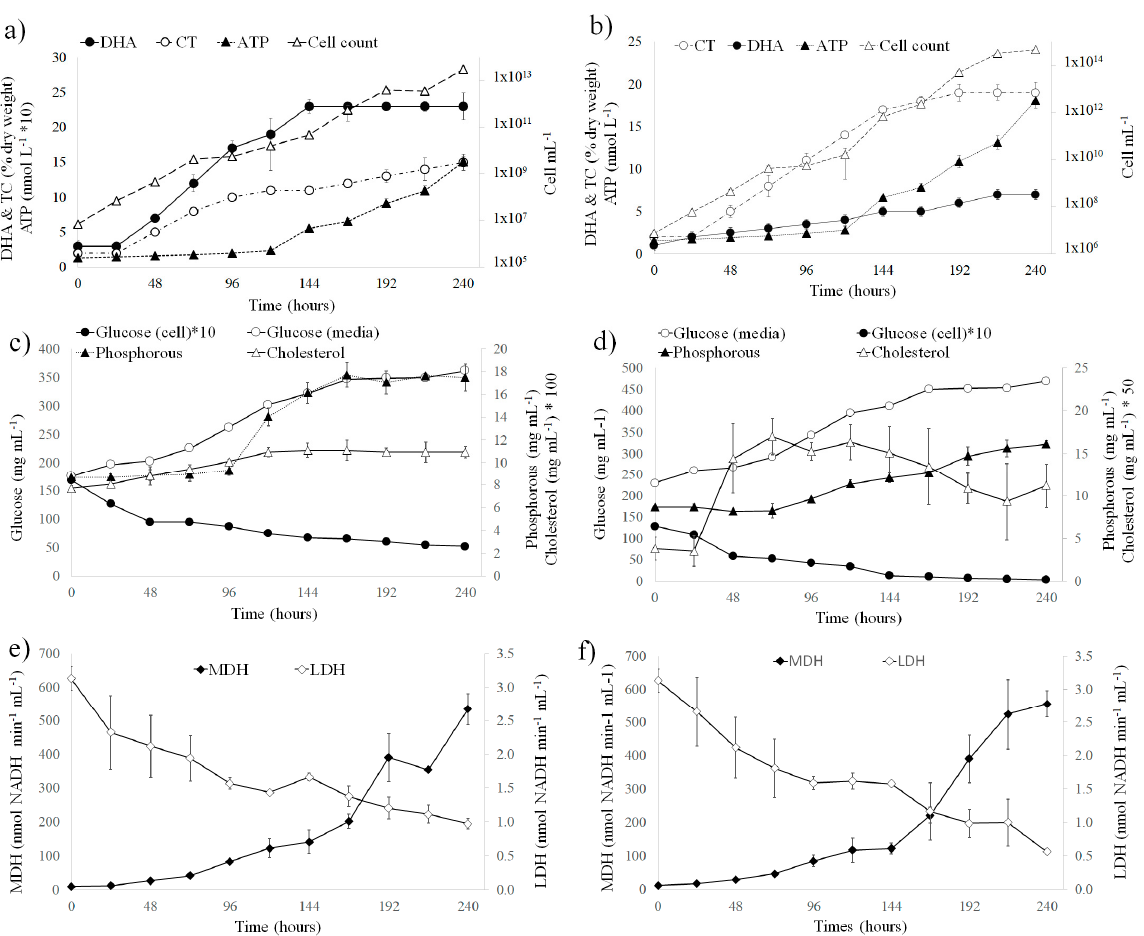
Figure 4. Average production ± SD of metabolic parameters determined for the NCYC4007 and NCYC1146 strains, cultivated in RGM at 15 ◦ C. ( a , b ) Docosahexaenoic acid production (DHA), total carotenoids (TC), live microbial biomass (ATP) and cell count of strains NCYC4007 and NCYC1146, respectively. ( c , d ) Intracellular glucose concentration and in the culture media, total phosphorus and intracellular cholesterol of strains NCYC4007 and NCYC1146, respectively. ( e , f ) Enzymatic activities of MDH and LDH of the strains NCYC4007 and NCYC1146, respectively.